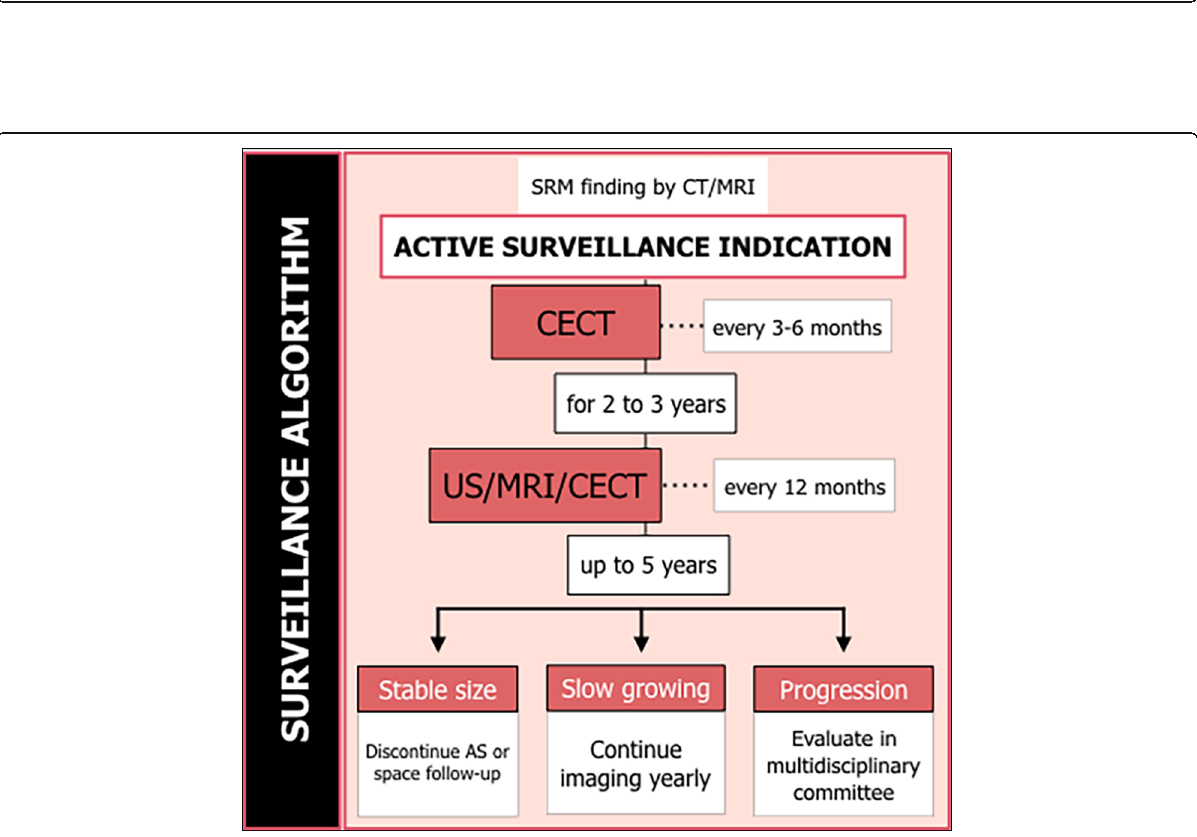
Fig. 7 Suggested active surveillance management algorithm. Contrast-enhanced computerized tomography (CECT), ultrasound (US), and magnetic resonance